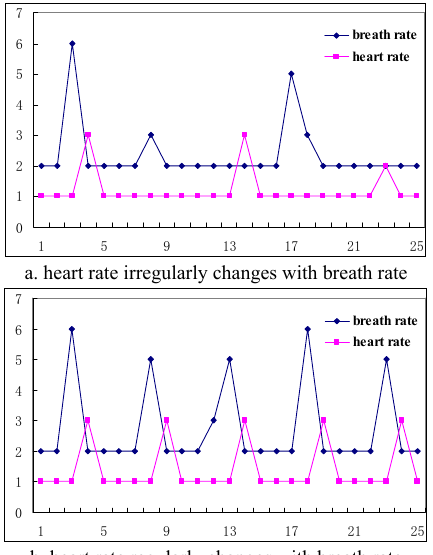
Fig. 2. Intervention